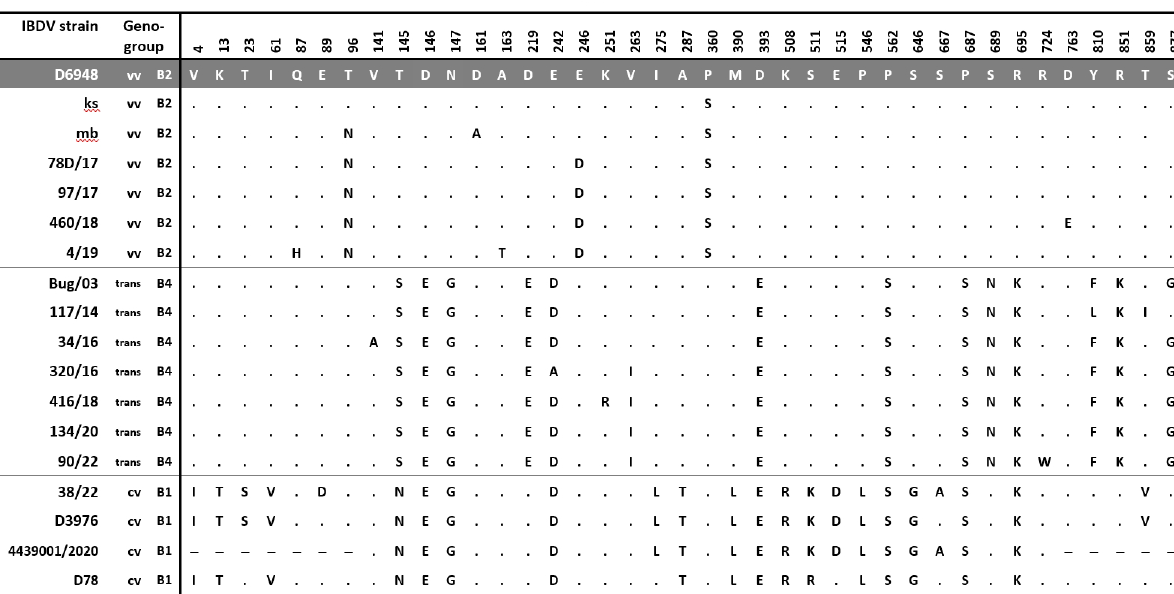
Figure 5. Comparison of amino acid substitutions in viral proteins encoded by segment B between Polish and reference strains. Dots show identity with D6948, while dashes indicate the lack of